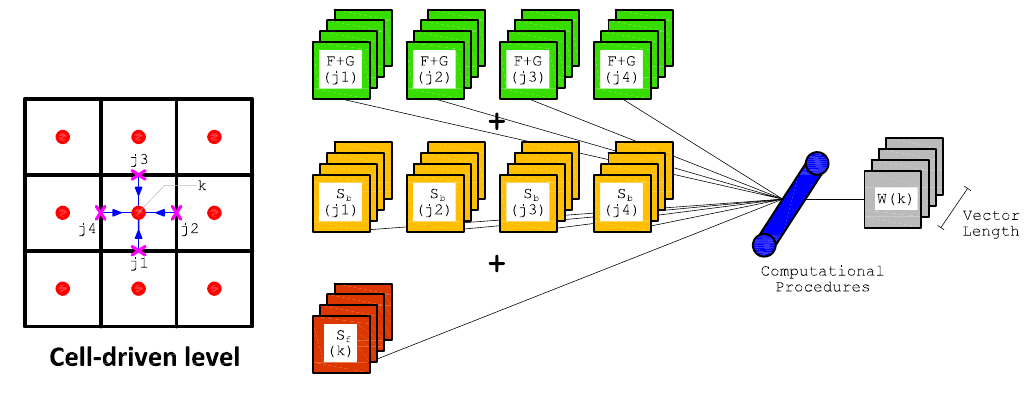
Figure 2. Vectorization for advancing the solution in the cell-driven